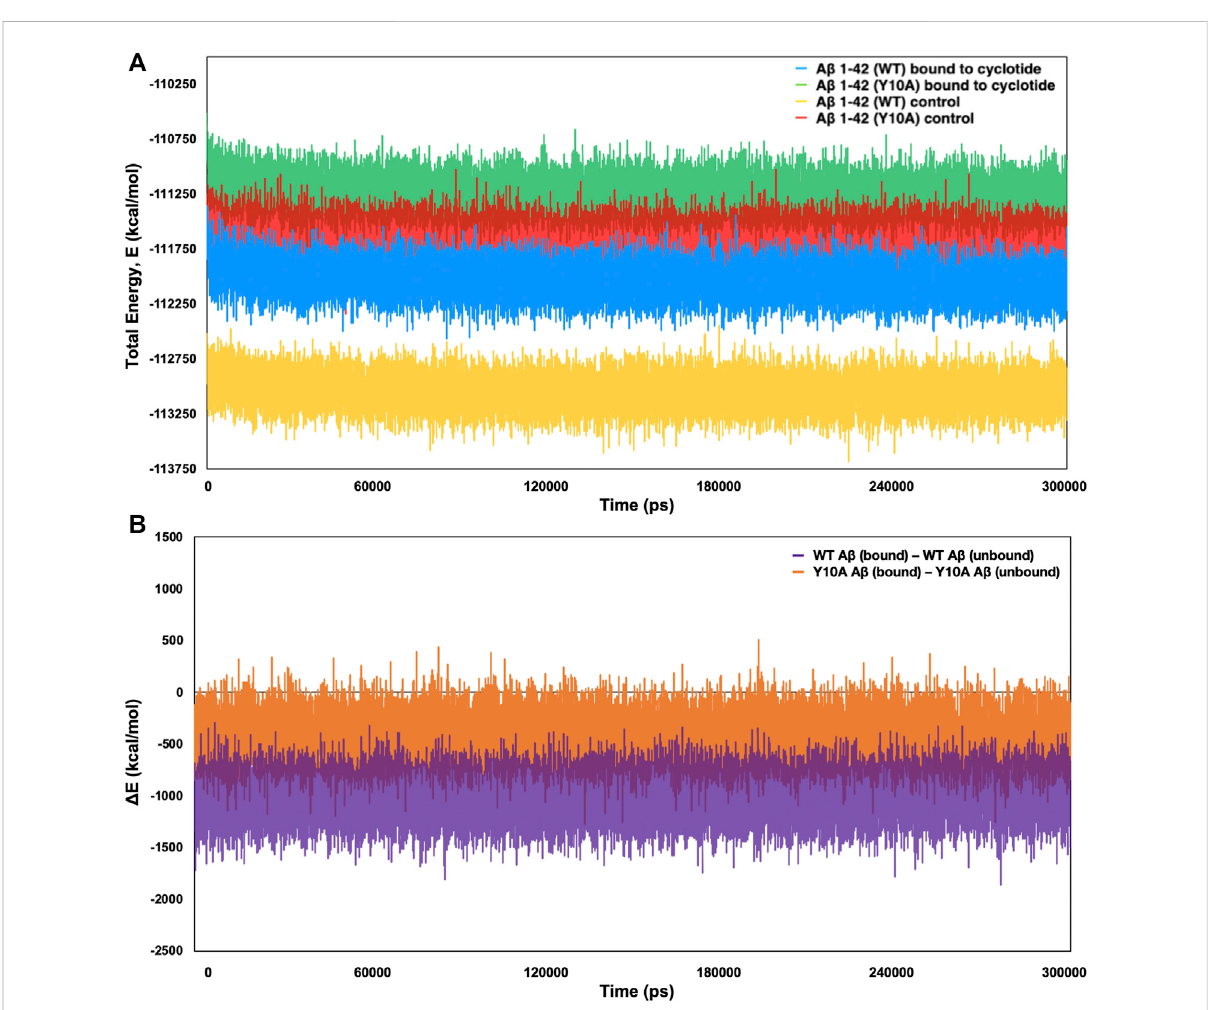
FIGURE 5 Total (E) and difference ( Δ )inenergy terms, Δ E = E bound — E unbound of thesystem as afunction of MDsimulation time (300 ns) for wild-type and Tyr10Ala mutant A β 1-42 (PDB ID: 2NAO) in complex with cyclotide (PDB ID: 2LAM) and their corresponding control (unbound) trajectories. (A) The total energy and (B) Δ E terms for the different systems are plotted in different colours and mentioned in the corresponding legend. Both the thermodynamic parameters are plotted in the units of kcal mol − 1 vs. time (ps).